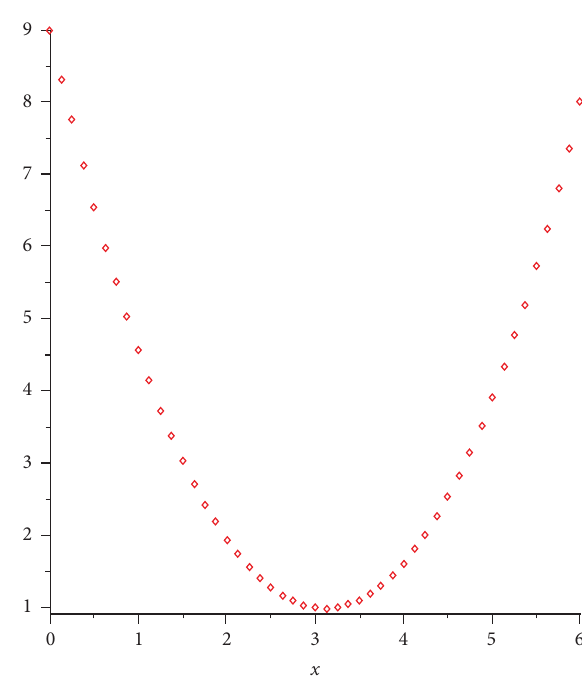
Figure 6: An example of different values of shape parameters t and s.